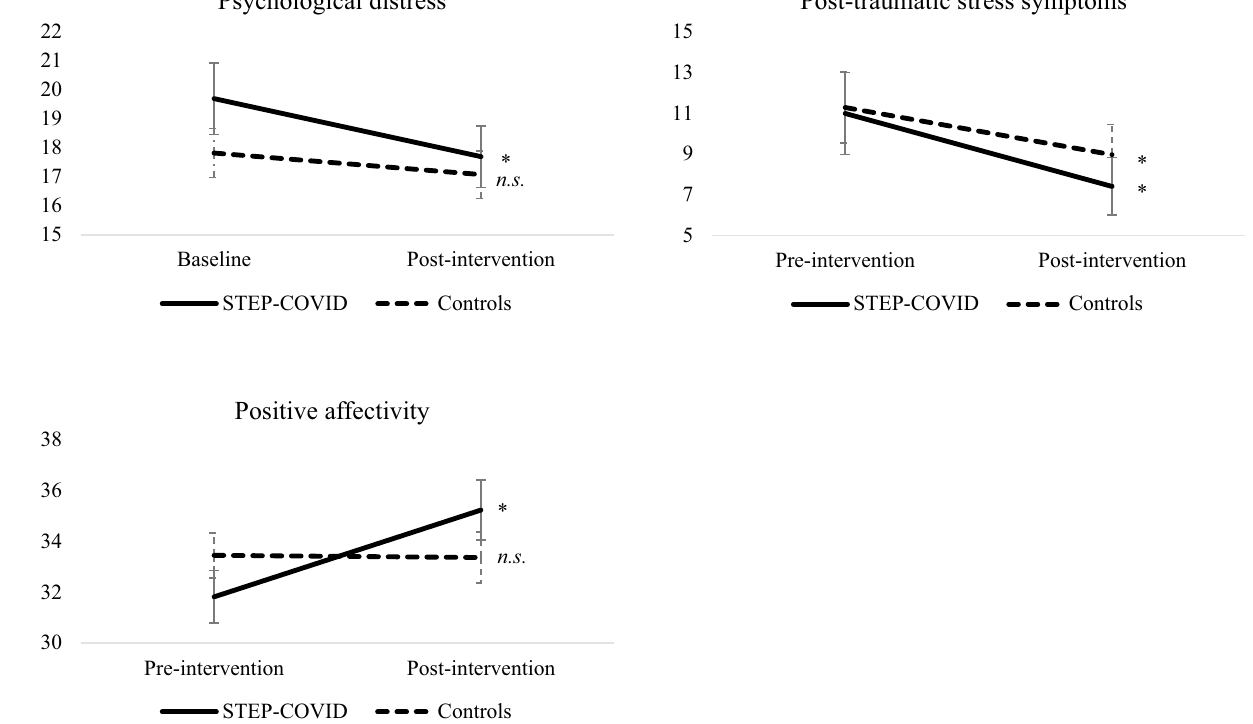
Figure 2. Change in mental health symptoms between baseline and post-intervention assessments. Note Length of the error bars represent the standard error for the mean. Means, SD and t tests are reported in Table S1. * p < 0.05; n.s. = non-significant.